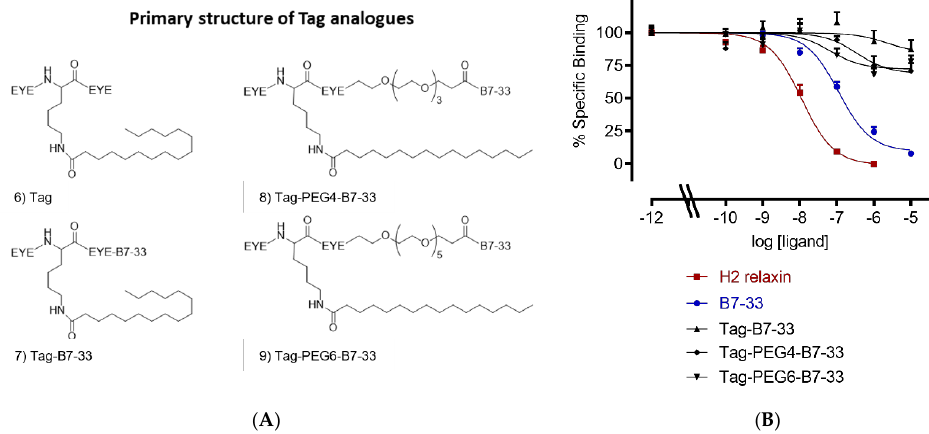
Figure 3. Primary structure and sequence of lipidated analogues. ( A ) Primary structure of tagged B7-33 analogues: (6) Tag structure, (7) Tag-B7-33 with no spacer, (8) Tag-PEG4-B7-33 with PEG4 spacer, and (9) Tag-PEG6-B7-33 with PEG6 spacer. ( B ) Eu-H2 relaxin competition binding of apidated analogues in HEK-7BP cells. The data are the result of n = 3–4 independent experiments and expressed as mean ± SEM.